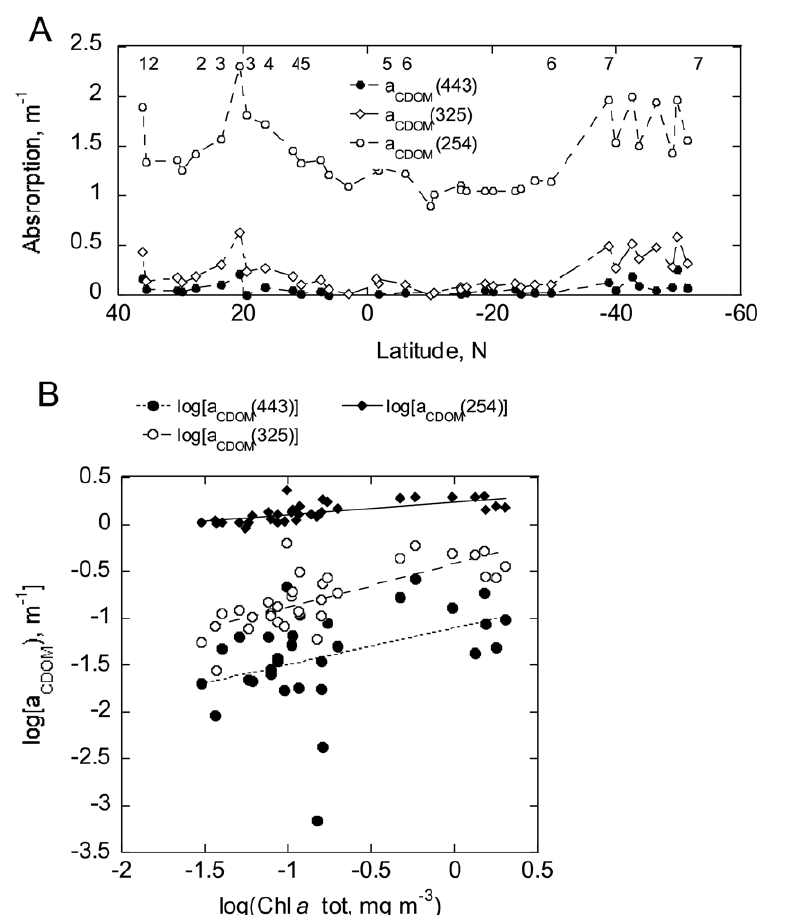
Fig. 8. – A, latitudinal variation of a (443), a (325) and a (254) (m –1 ) along the TransPEGASO transect; B, relationships of CDOM CDOM CDOM a (443), a (325) and a (254) with Chl a _tot (mg m –3 ). The equations of the lines are log[a CDOM CDOM CDOM n=31, r 2 =0.16, p<0.05; log[a (325)]=0.46*log(Chl a _tot) –0.42, n=31, r 2 =0.55, p<0.0001 and log[a CDOM n=35, r 2 =0.47, p<0.0001.